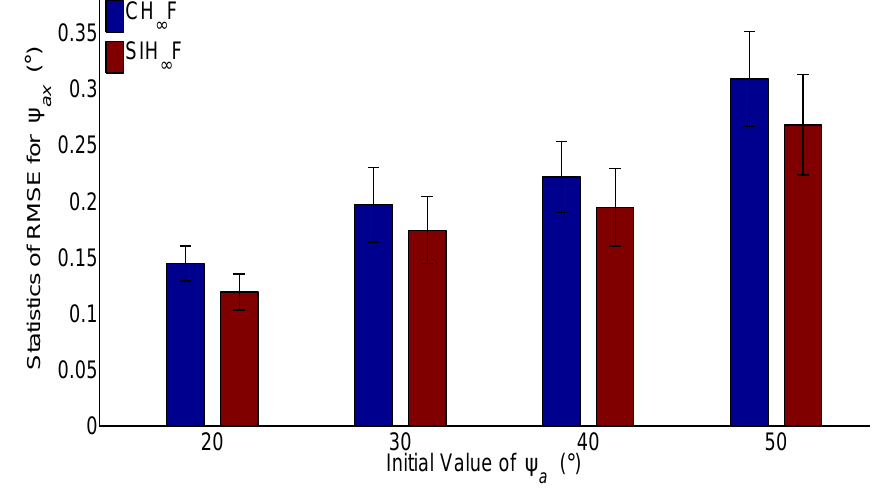
Figure 8. Statistics of RMSE for ψ ax